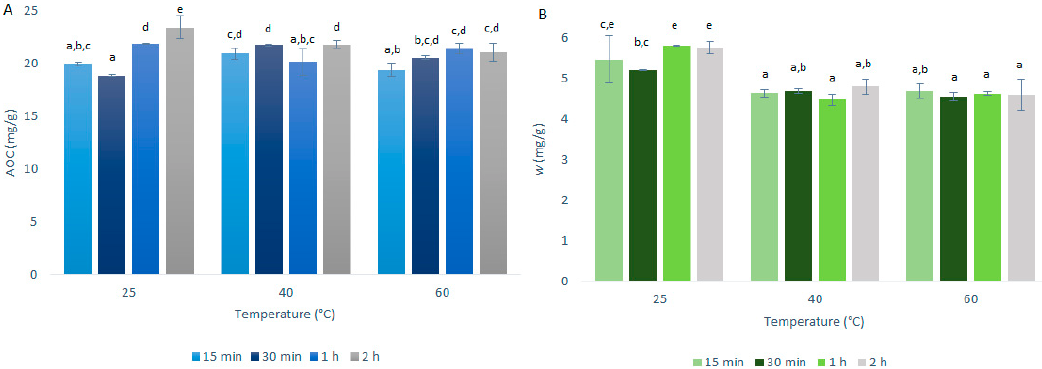
Figure 3. Quercetin equivalent antioxidant capacity (AOC) ( A ) and mass fraction (w) of quercetin ( B ) for the time courses of the primary extractions using conventional maceration with the different mass-to-liquid ratios and 50% ethanol at 25 °C. Data are expressed as mg quercetin per g dry matter, as means ± standard deviation. Different letters within each histogram indicate significant differences ( p < 0.05; ANOVA).